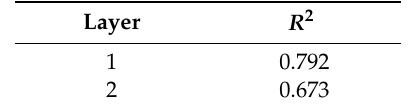
Table 4. The R 2 of each Table 4. The (cid:1844) 2 of each layer.